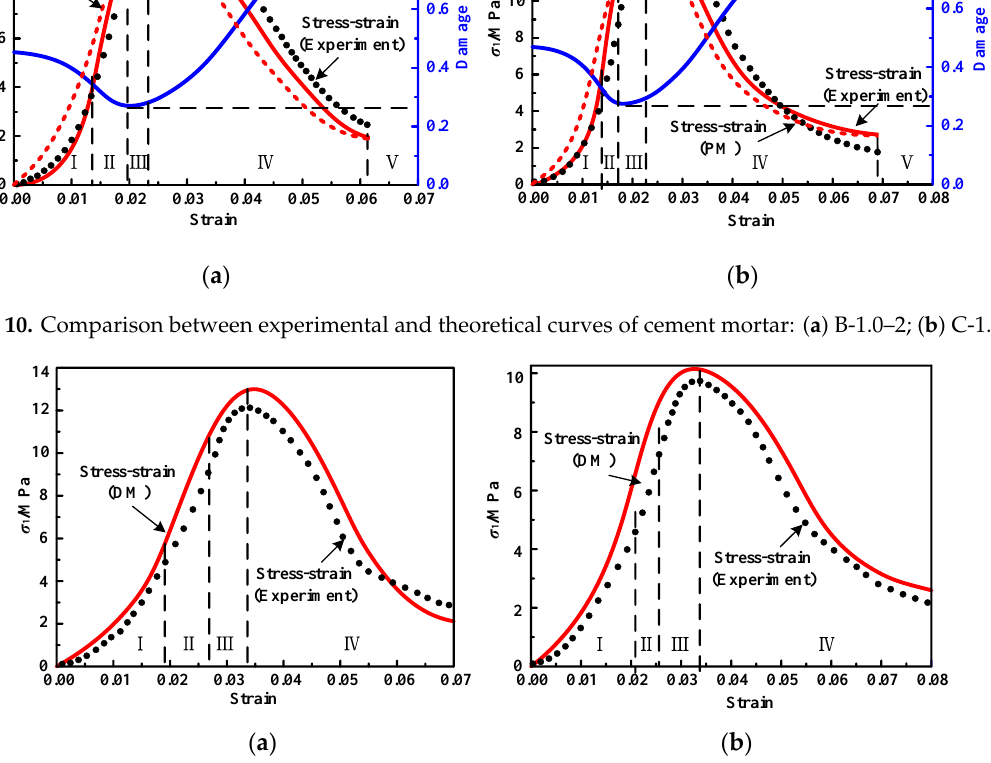
Figure 10. Comparison between experimental and theoretical curves of cement mortar: ( a ) B-1.0 – 2; ( b ) C-1.0 – 3.